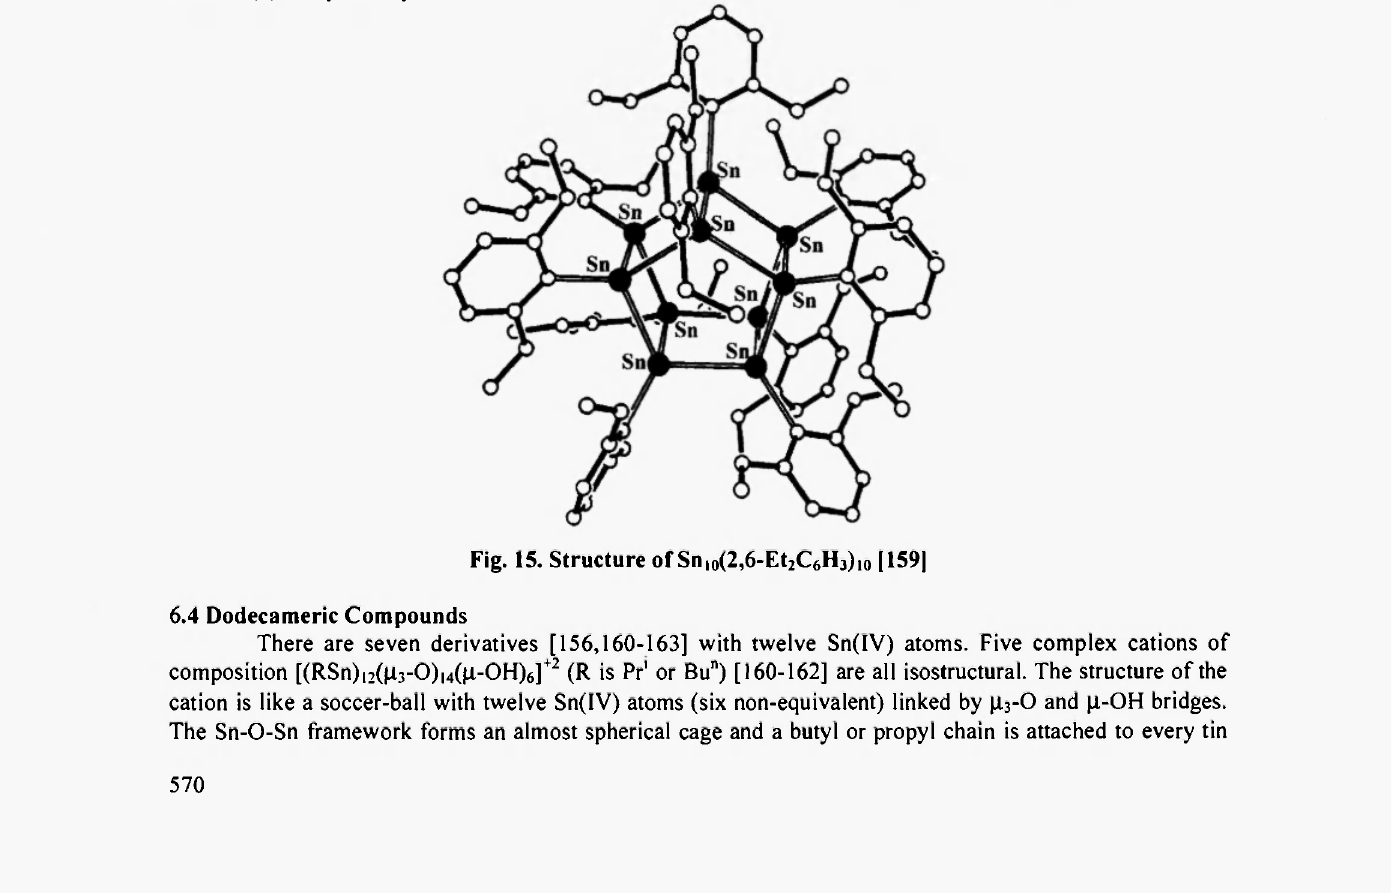
Fig. 14. Structure of Sn II 9 ^-C 5 Me4(SiMe 2 Bu , )} 6 Cl|2